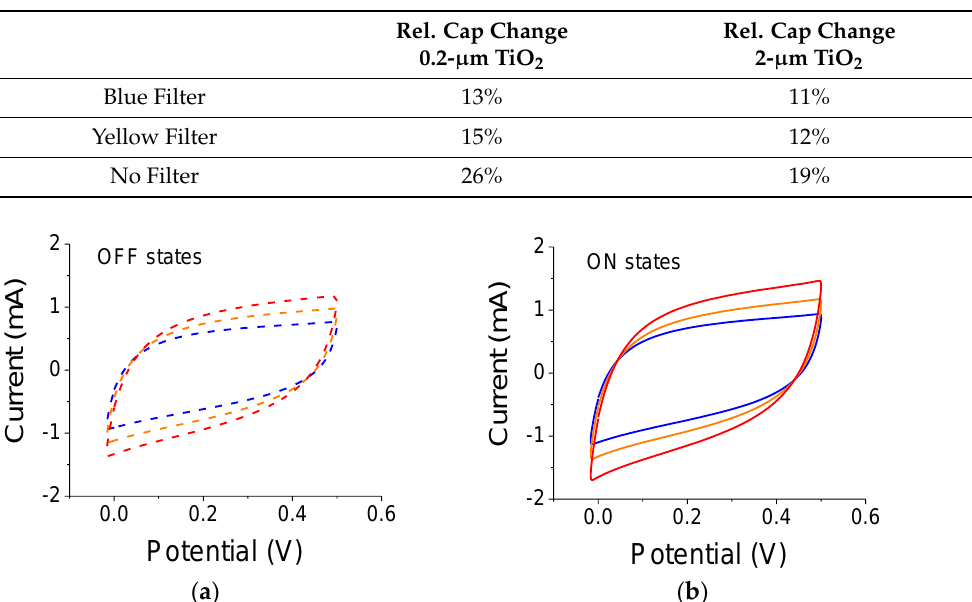
Table 3. Relative capacitive change using a C-V measurements in a 3-electrode setting when illumi- nated by a 75 W white-light source.